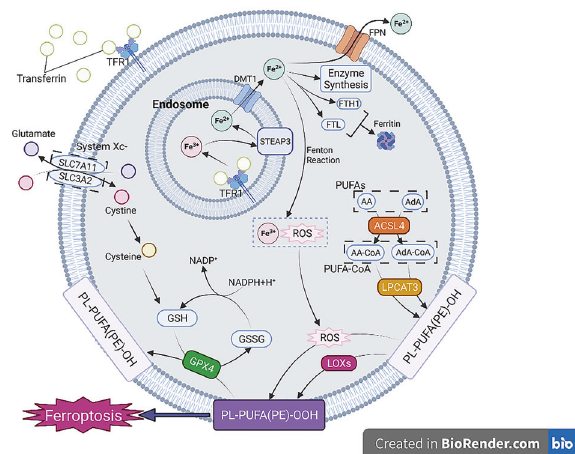
Fig. 1 The overview of ferroptosis. The process of ferroptosis is associated with three main metabolisms (iron, lipid and amino acid metabolisms). Cells intake iron into endosome in the form of Fe 3 + through binding between transferrin and TFR1. Fe 3 + can be reduced to Fe 2 + by STEAP3, which is then transported into cytosol by DMT1. Most of Fe 2 + can be released by FPN, used for enzyme synthesis or stored in ferritin. The rest of Fe 2 + may change into Fe 3 + and ROS by Fenton Reaction. ROS accumulation will cause ferroptosis for it make PL-PUFA(PE)-OH oxidized into PL-PUFA(PE)-OOH. System Xc-, com- posed of SLC7A11 and SLC3A2, acts as a transporter responsible for releasing glutamate and intaking cysteine, which can be further transformed in to cysteine that is an important component of GSH. GSH can deoxidize PL-PUFA(PE)-OOH back into PL-PUFA(PE)-OH with the help of GPX4, which protects cells from ferroptosis. PUFAs, especially AA and AdA, are changed into PUFA-CoAs which is modi fi ed by LPCAT3 in order to be integrated into cell